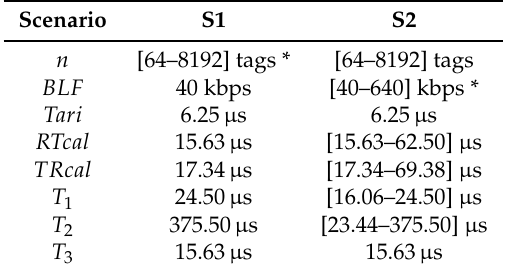
Table 4. Parameters used in the simulations. * indicates the control